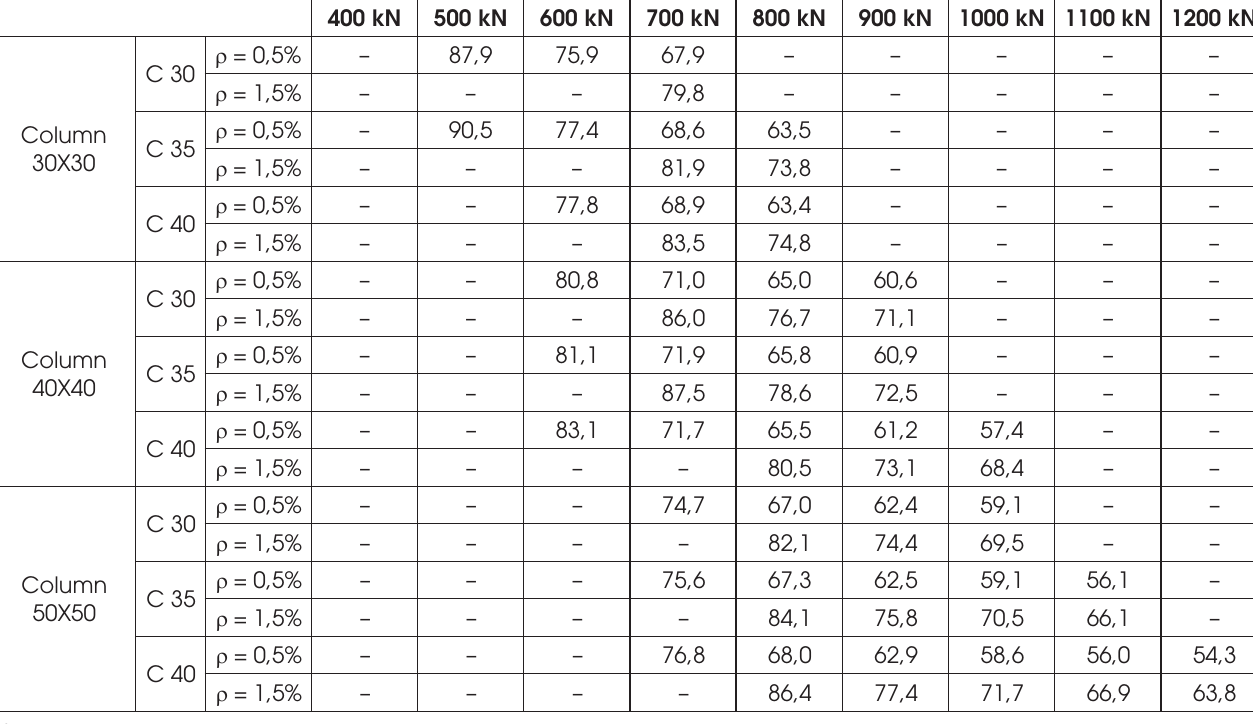
Percentual reduction by Comparison 4, considering s